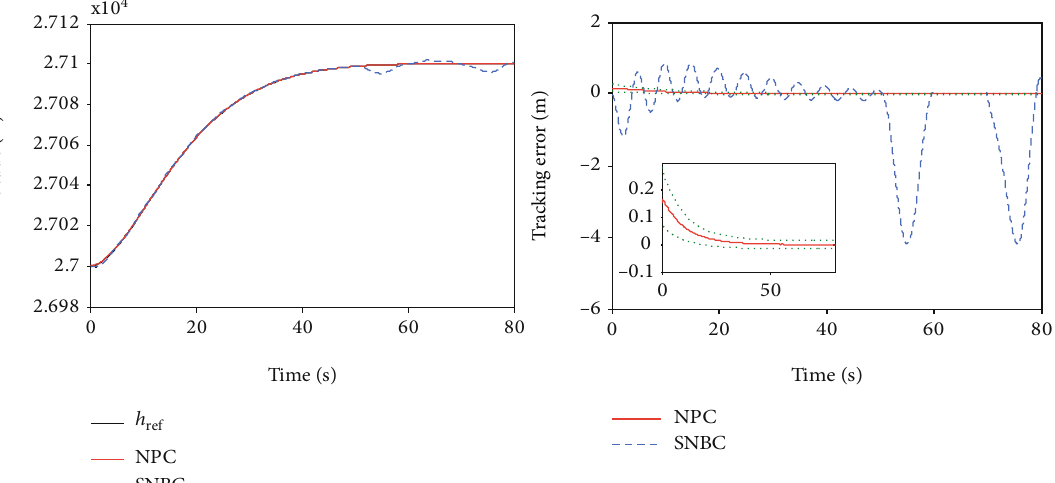
Figure 5: Altitude tracking performance of the case.